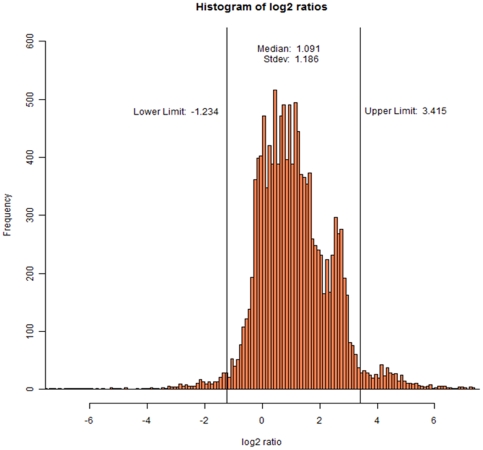
Statistical analysis using 95% confidence settings for determining the limits of protein log2 ratio values linked to differential regulation.These limits are >3.415 and <−1.234. Thus, a protein with a value <−1.234 indicates higher abundance upon antibiotic stress, whereas a protein with a value >3.415 indicates higher abundances in the absence of antibiotic.